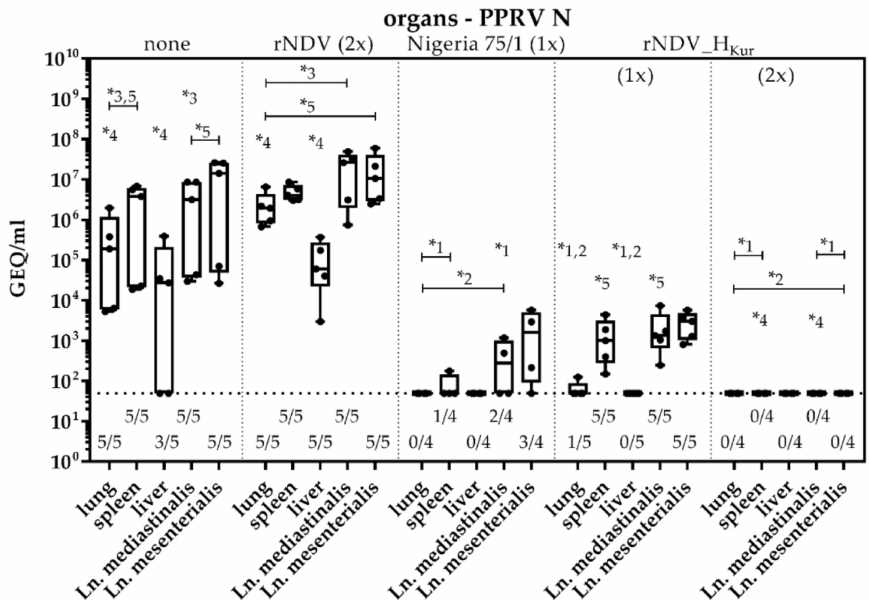
Figure 9. Analyses of postmortem organ samples. Five goats each were either left unvaccinated (group 1), double inoculated with rNDV (group 2), single vaccinated with PPRV Nigeria 75 / 1 (group 3), single vaccinated with rNDV_H Kur (group 4), or double vaccinated with rNDV_H Kur (group 5). All goats were infected with PPRV Kurdistan / 11 three weeks after immunization. Goats from group 1 and 2 were euthanized on day 9 post challenge infection (dpc), except for two animals from group 1, which were euthanized 14 dpc. All goats from group 3, 4 and 5 were euthanized 28 dpc. Samples from lung, spleen, liver, and mediastinal and mesenterial lymph nodes were analyzed by quantitative real-time RT-PCR (RT-qPCR) for the presence of PPRV N specific RNA. Values were transformed to genome equivalents (GEQ) using calibration curves of defined RNA standards that were included within each RT-qPCR run. Boxplots also depict individual values for a better overview. The number of positive samples relating to the total number of samples tested by RT-qPCR is given below the boxplot. Asterisks (*) and numbers above datasets indicate significant di ff erences ( α = 0.05) between respective groups at the same